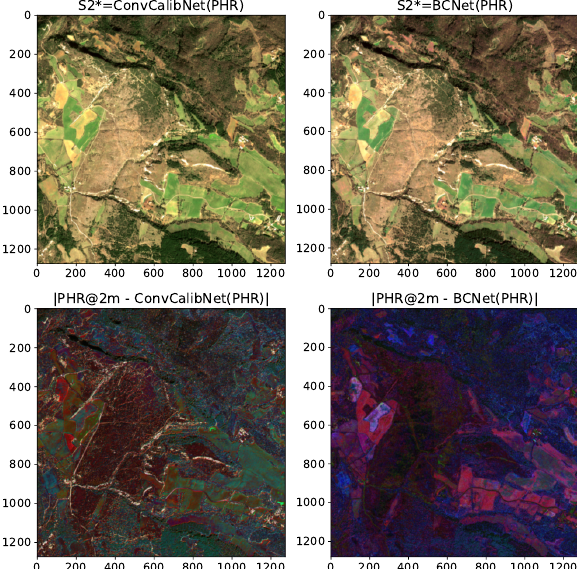
Figure 8. Prediction and alteration of Pleiades image for ConvCalibNet and BCNet at 2m resolution.